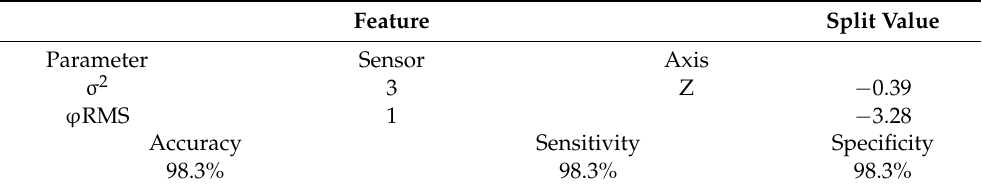
Table 4. Split Values, Accuracy, Sensitivity and Specificity for Bird-Dog Decision Tree calculated according to [43].